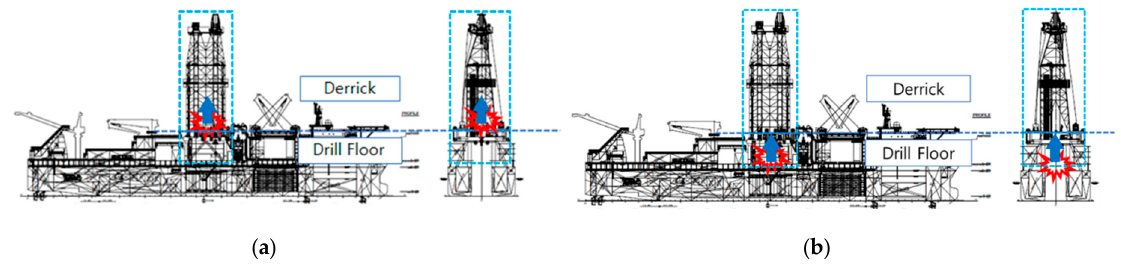
Figure 4. Blowout location ( a ) on the drill floor and ( b ) under the drill floor.